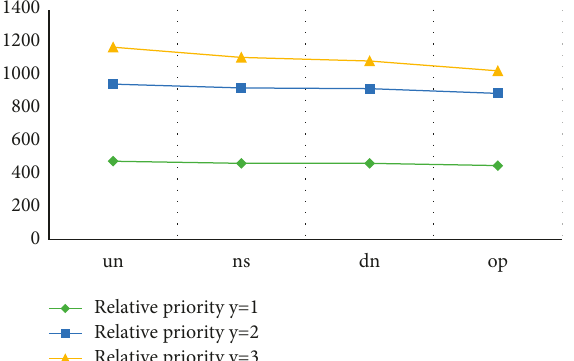
Figure 4: Ranking results using the COPRAS method with